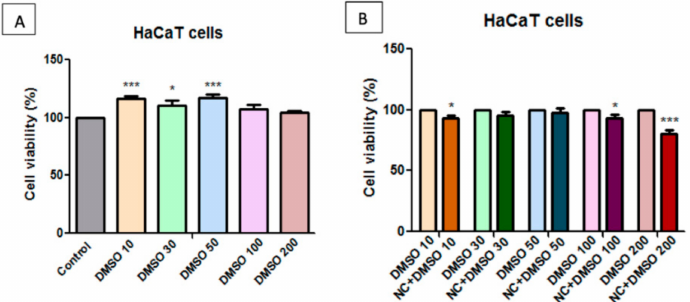
Figure 8. A —E ff ect of dimethyl sulfoxid (dmso) concentrations on human keratinocytes (hacat) cell viability at 24 h post-stimulation. the results are presented as cell viability rate (%) normalized to control cells (no stimulation); B —the e ff ect of di ff erent concentrations of nanocomposite (nc) samples on hacat cell viability. results are presented as cell viability rate (%) normalized to solvent (dmso) treated cells. to determine the statistical di ff erences one-way anova was employed, followed by bonferroni post-test (* p < 0.05; *** p <